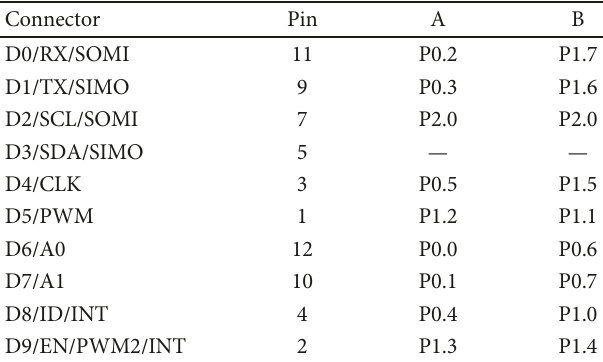
Table 1: Mapping of CC2510 pins onto the AraMiS module.